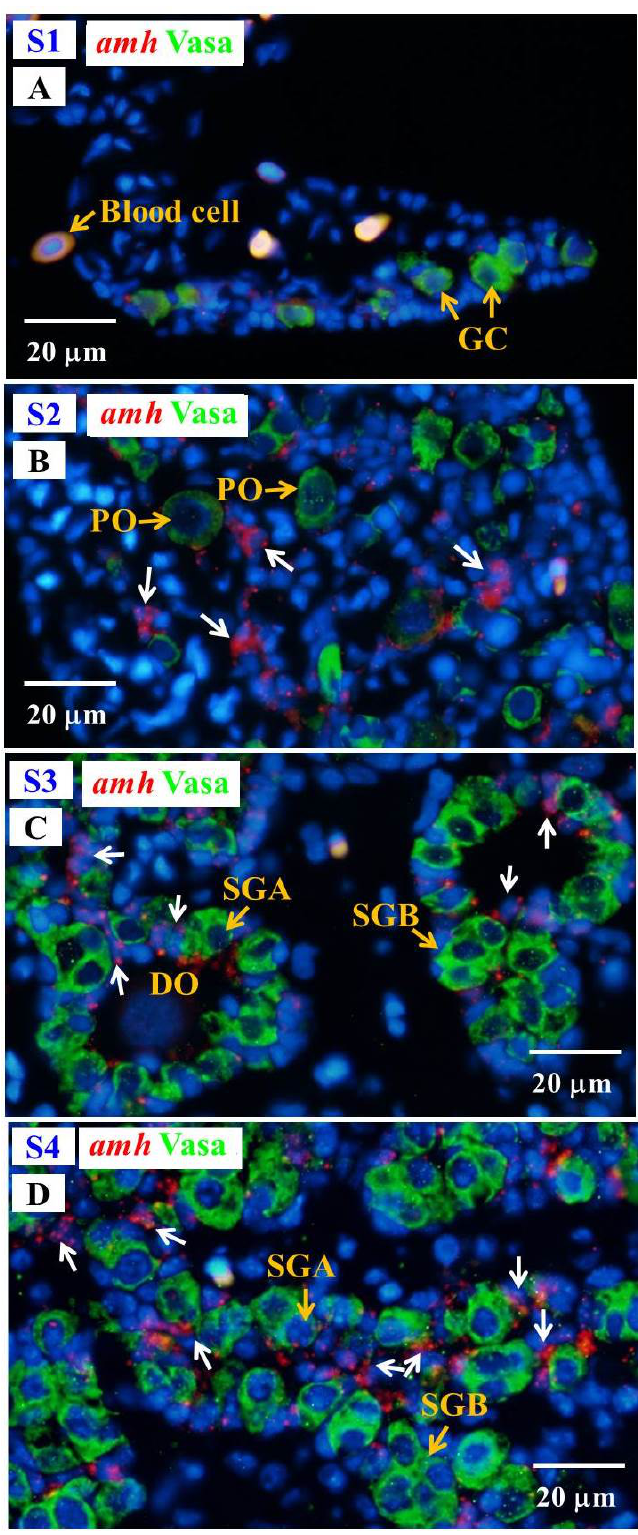
Figure 8. Gonad transverse sections, stained with ISH fluorescence for amh transcripts (red, white arrow) and IHC for the Vasa proteins (green) in male Japanese eel at various stages of testicular differentiation. ( A ) S1 stage, undifferentiated gonad. ( B ) S2 stage, early differentiating gonad. ( C ) S3 stage, late differentiating gonad. ( D ) S4 stage, differentiated testis. GC, germ cell; PO, primary oocyte; DO, degenerating oocyte; SGA, spermatogonia A cell; SGB, spermatogonia B cell. Signals of gsdf transcript were observed in the Vasa-negative somatic cells in the gonads at undifferentiated stage (S1); furthermore, intensive hybridization signals were detected in somatic cells of the gonads at differentiating stages (S2 and S3), while gsdf